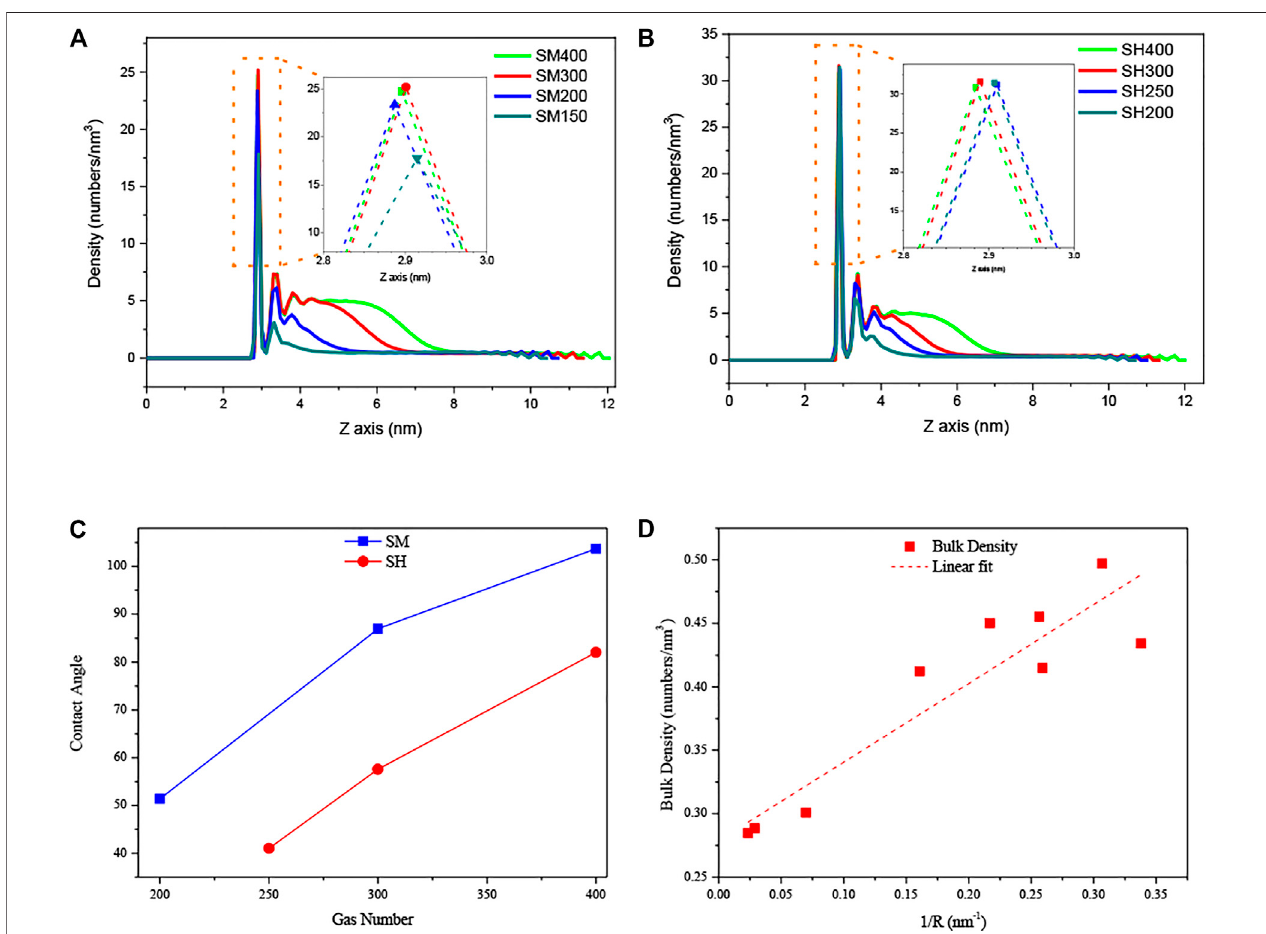
FIGURE 6 | Density distribution curves of gas particles along Z-axis and contact angles of INBs for hydrophilic substrates patterned by hydrophobic patch: (A) S M patch, (B) S H patch, (C) contact angles of INBs for S M and S H patches, (D) gas densities in bulk as a function of curvature of INBs. Note: the number of 400, 300, 250, 200, and 150 represent thenumber ofgasmolecules used in thesimulations, where theliquid molecule number was4,000 forall ofthesecases; the density distribution curves were obtained from the gas density of the center axis of INBs (averaged from 4.5 to 5.5 nm of X-axis).